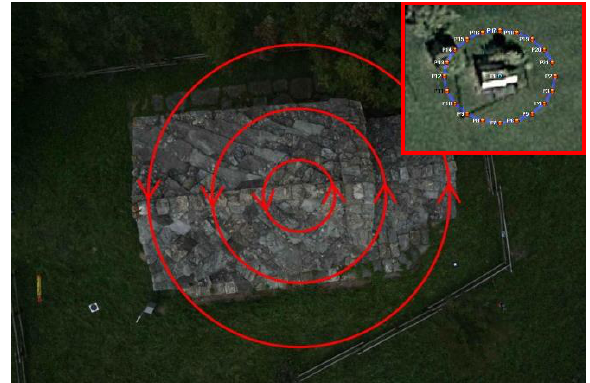
Figure 5 . Schema of the circular flight for oblique images acquisition (a screen shot of the Mikrokopter tool is in the top right part of the image)